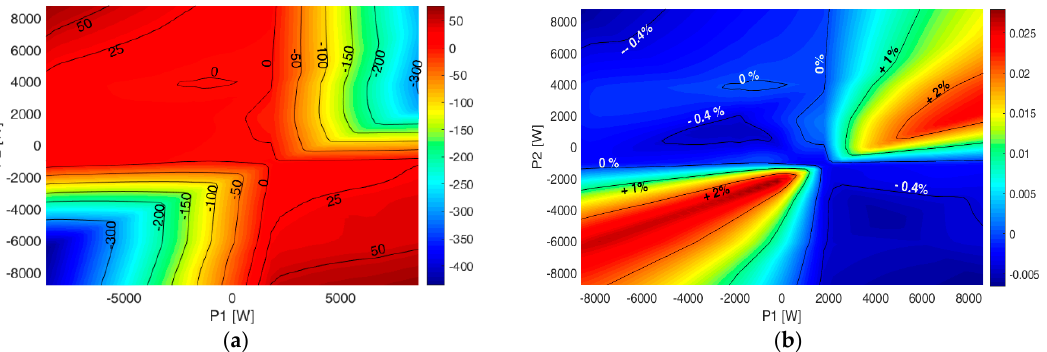
Figure 9. Comparison between 4SC and 3SC ( a ) 3SC losses—4SC losses [W] ( b ) 3SC efficiency—4SC efficiency.